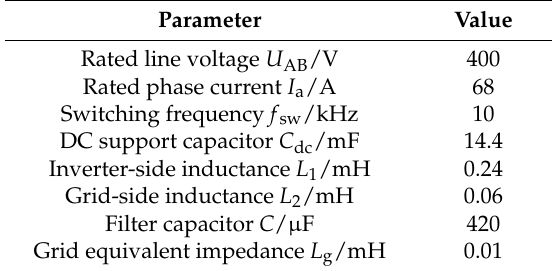
Table 4. Basic parameters of 500 kW